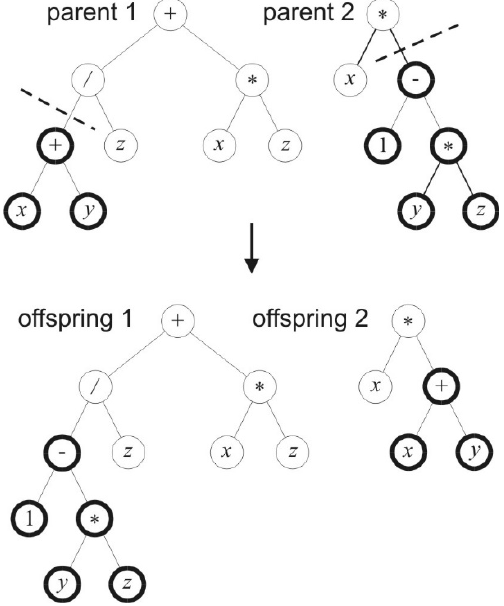
Figure 4. Crossover operation (out of two parental organisms, the offspring with randomly distributed genetic material are evolved).